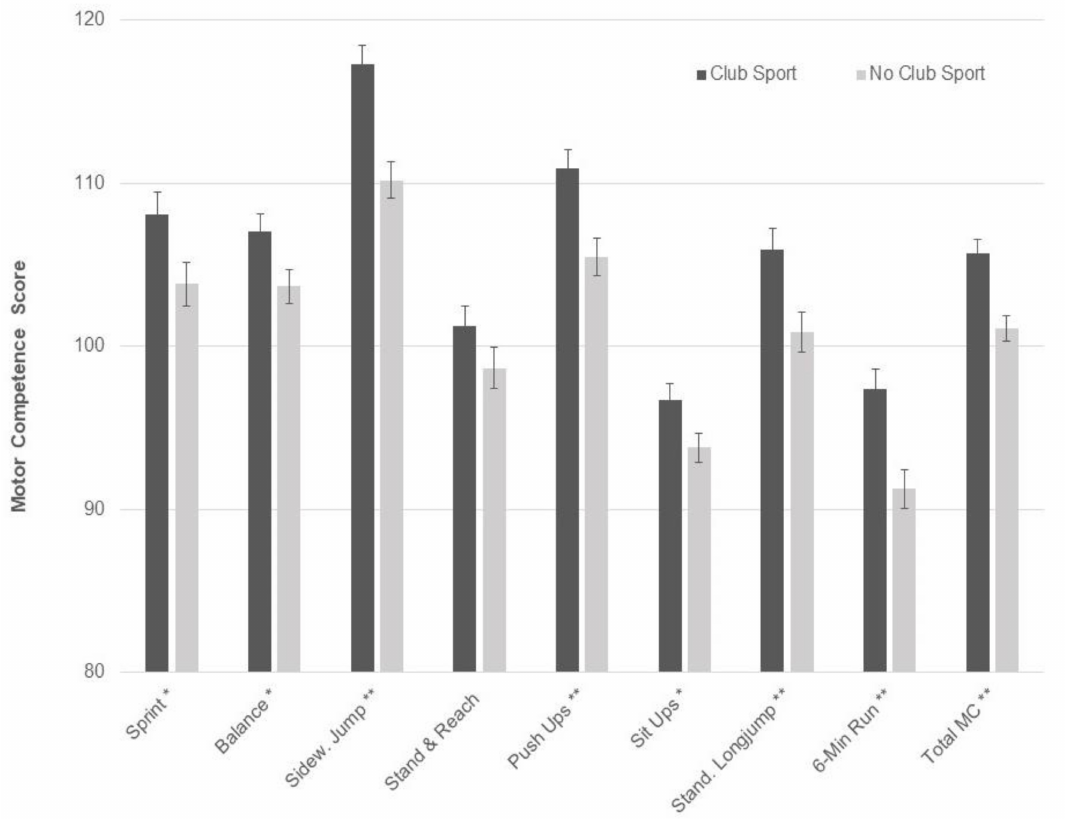
Figure 1. Main effects of club sports participation on motor competence based on 2 × 3 multivariate analysis of variance (MANOVA) (club sports by Water/low fast food (FF)). Values are sex-and age-normalized means with S.E.; * p < 0.050 ** p < 0.010. MC: motor